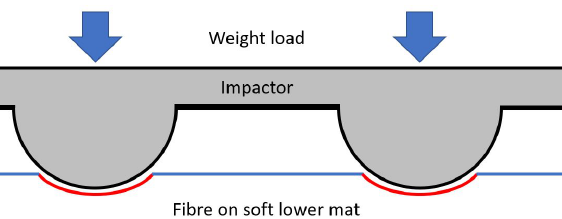
Figure 1. The overall sensor design, showing how weight applied from above pushes the impactor to deform the bottom soft mat and fibre. The bent path length of the fibre is shown in red.